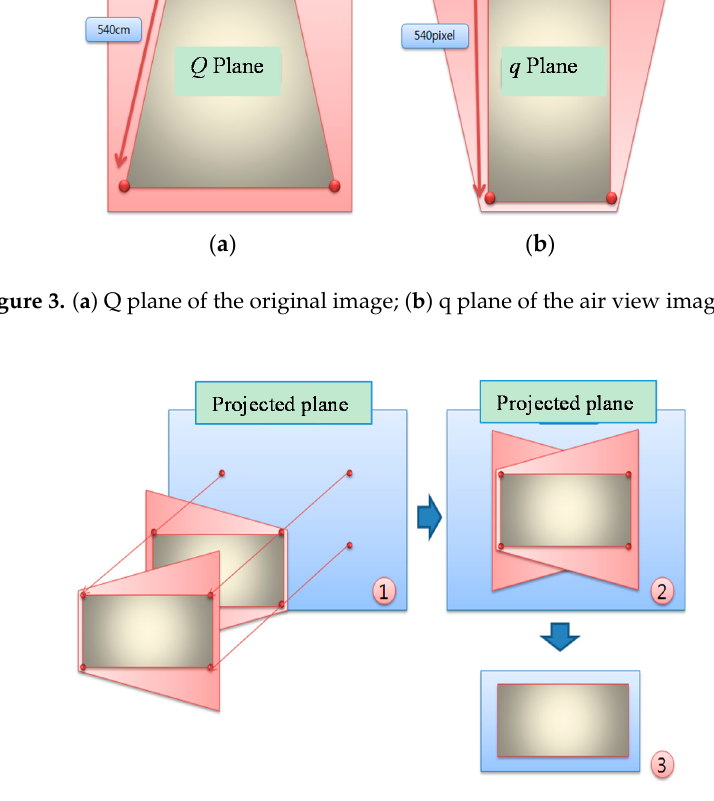
Figure 4. Extracting the two-dimensional map from two projected images by homography. ○ 1 Two images on the projected plane; ○ 2 A single united plane; ○ 3 An extracted two dimensional map. If multiple cameras are used for localization in more complex indoor environments, rotational relationships between image planes of the cameras are considered as shown in Equation (3).